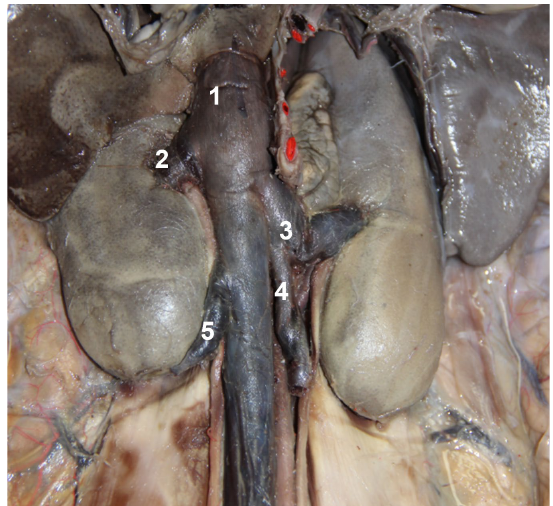
Figure 7. Topographic region of the kidneys. Viscera removed to show vascular distribution: 1. caudal vena cava receiving right ovarian vein (5); 2. right renal vein; 3. left renal vein receiving left ovarian vein (4).